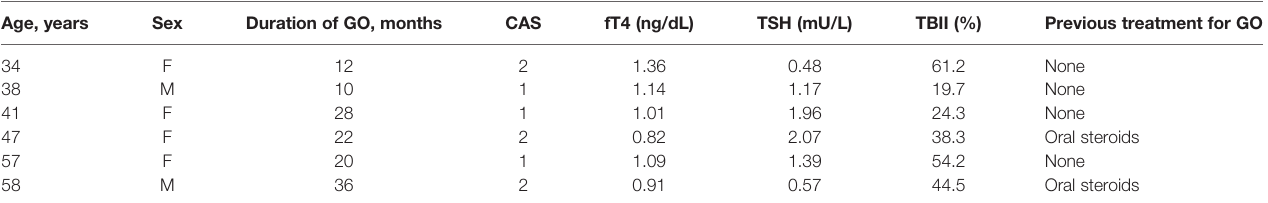
TABLE 1 | Clinical characteristics of the patients included in this